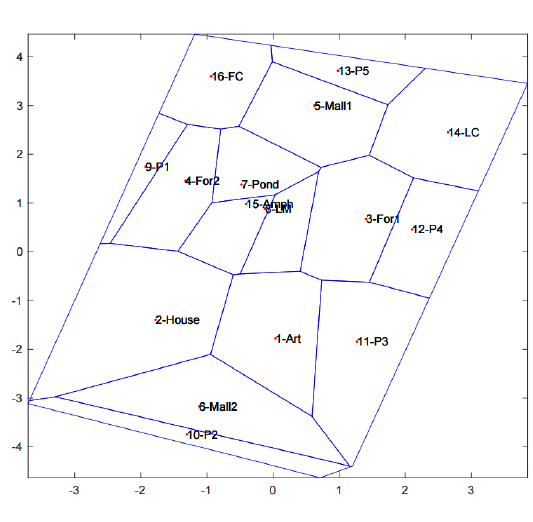
Figure 4. The graph shows the convergence of the function F ( S ) using the Nelder-Mead method.